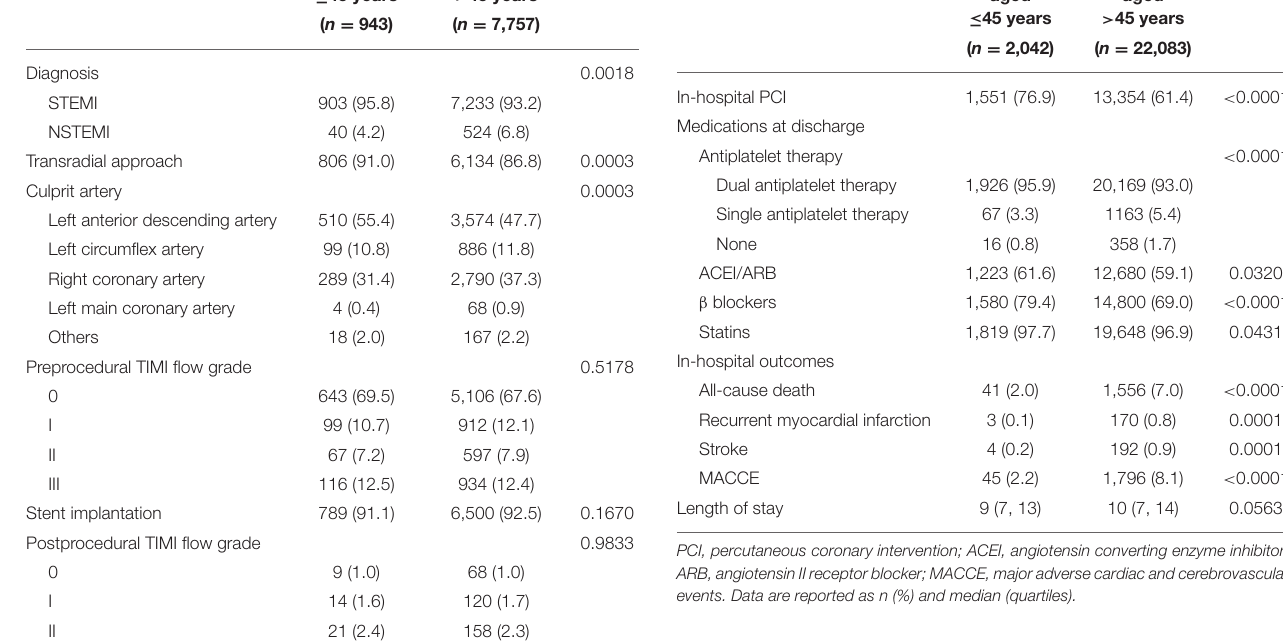
TABLE 2 | Angiographic characteristics of patients undergoing primary PCI in different age groups. Variables